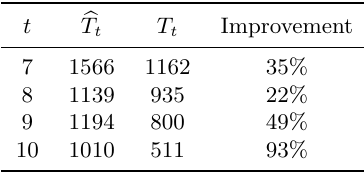
Table 7: Transaction estimates for July – October 2006 using PDM